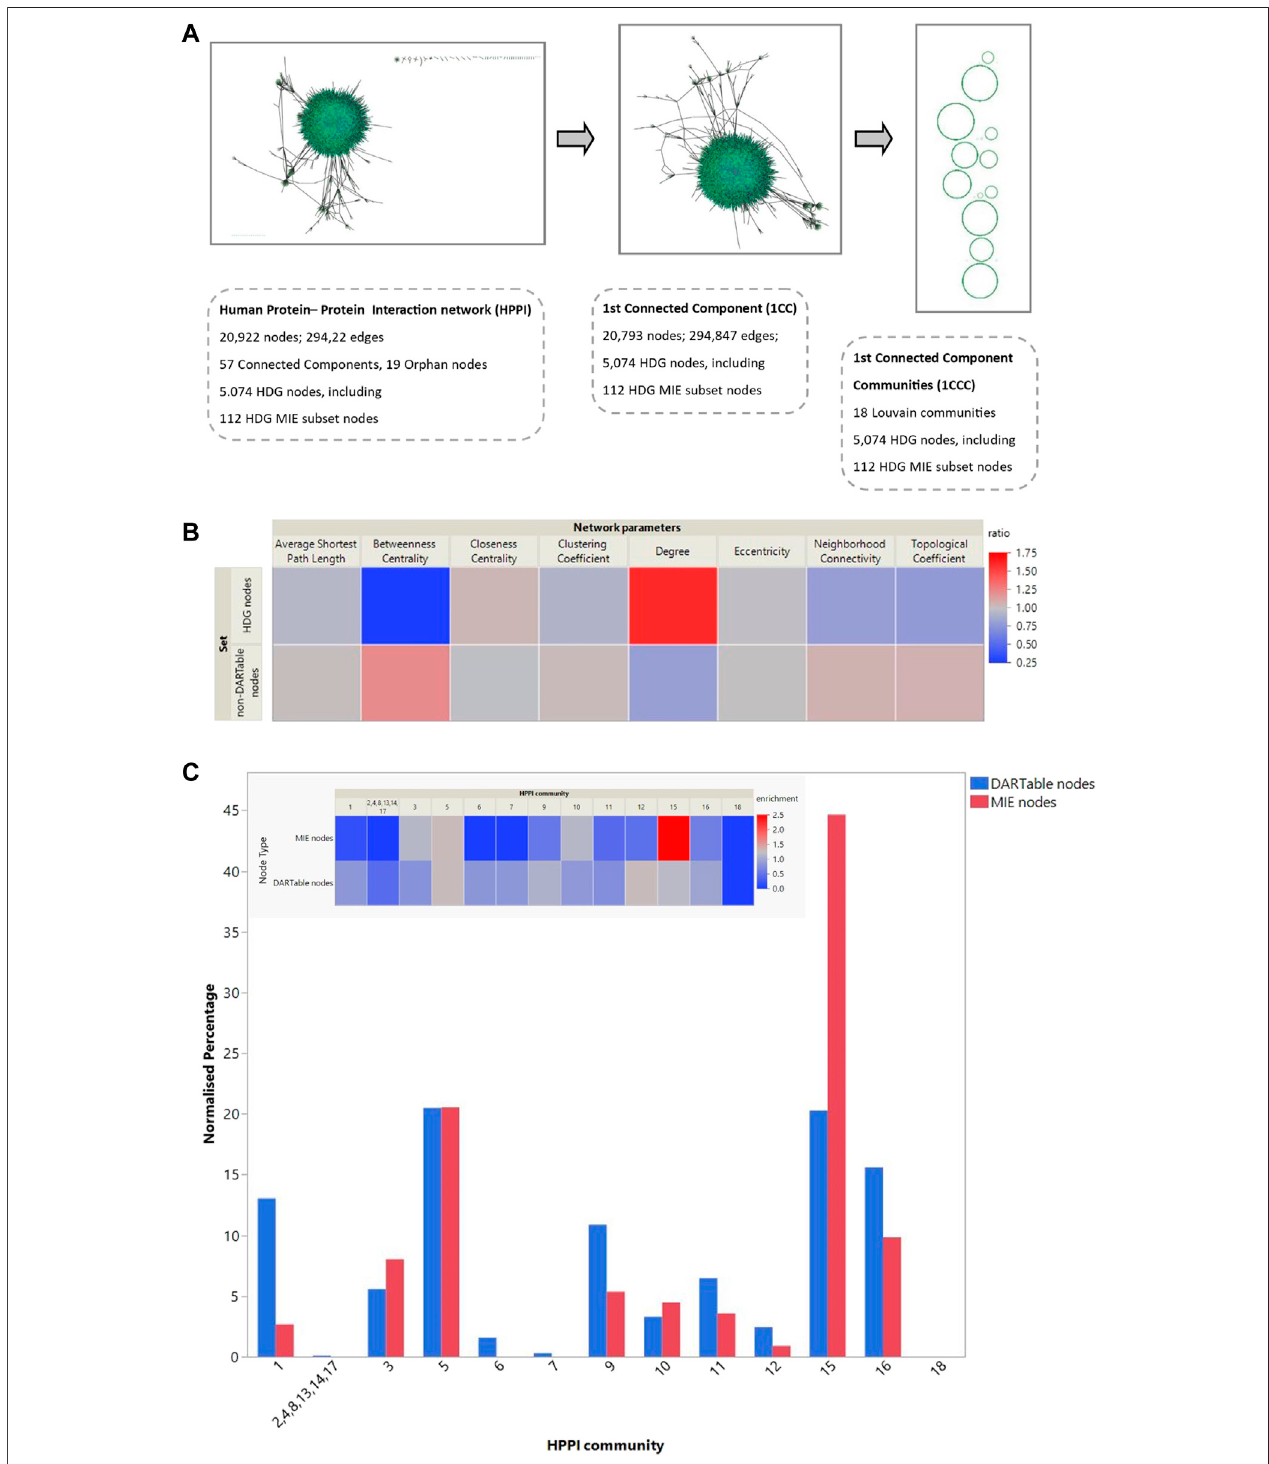
FIGURE3| NetworkanalysisoftheDARTablegenome. (A) .Networkanalysis:Usingthehumanproteininteractomeinformationwecreatedanetworkwith20,922 nodesand294,922edges,consistingof57connectedcomponents.TheHDGmappedto5,074nodesinthisnetwork.Thehighcon fi denceMIEsubsetmappedto112 nodes.WeextractedthelargestconnectedcomponentoftheHPPIforfurtheranalysis.Thisretained20,793nodesand294,847edgesfromthefullHPPIandcontained 5,069HDGnodes,includingall112thatmaptothefullHPPI.WeperformedLouvainclusteringtoidentify18communitieswithinthislargestconnectedcommunity andmappedtheHDGandtheknownMIEsubsettothesecommunities. (B) .WecalculatedtheaveragetopologicalpropertiesfortheentireHPPInetwork,thenon-HDG